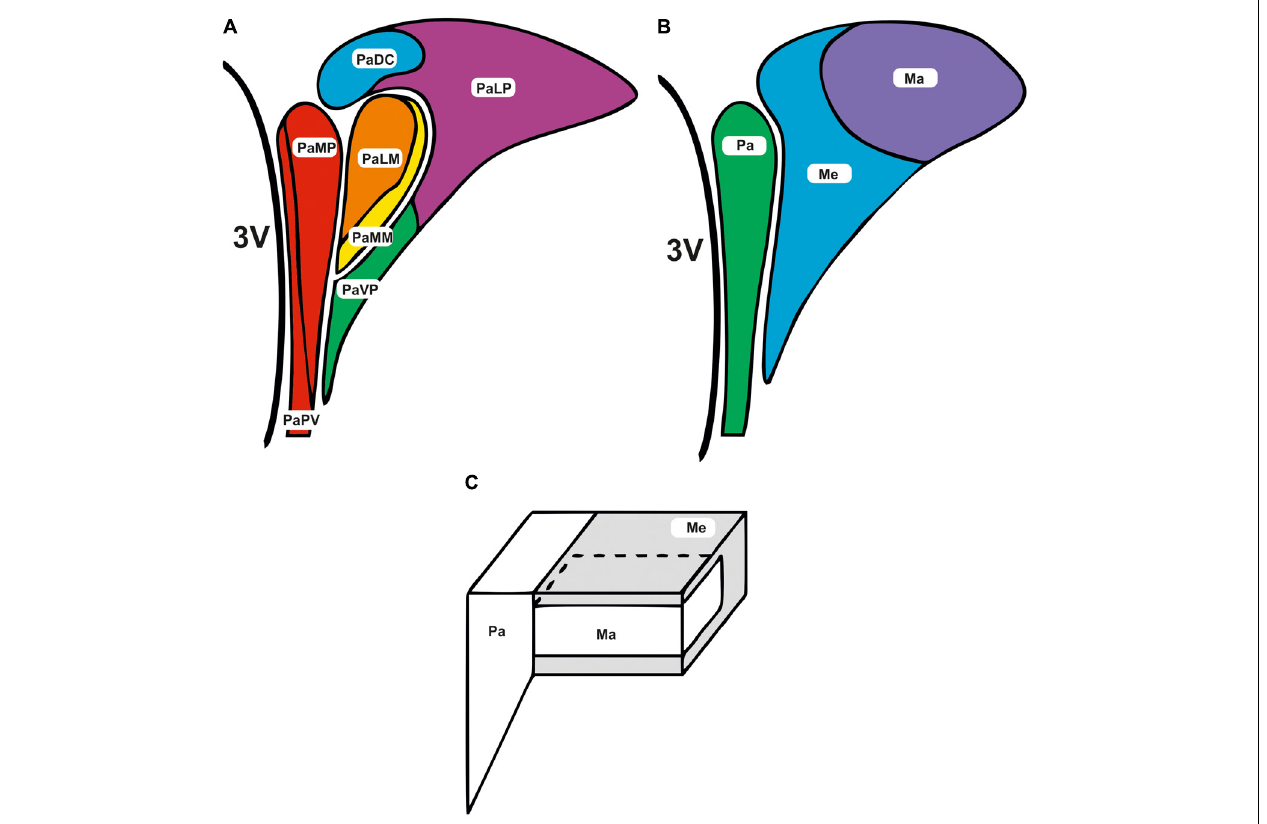
FIGURE 1 | Subdivisions of the paraventricular nucleus. The subdivisions of the PVN are adjacent to the third ventricle (3V). (A) Parvocellular and magnocellular regions are further subdivided into the following areas; lateral magnocellular (PaLM), medial magnocellular (PaMM), medial parvocellular (PaMP), lateral parvocellular (PaLP), periventricular subnucleus (PaPV), medial ventral parvocellular (PaVP), and dorsal cap (PaDC) (Paxinos and Watson, 1986; Koutcherov et al., 2000). (B,C) Alternatively the PVN can be divided more loosely into the parvocellular (Pa), posterior magnocellular lateral (Ma), and the intermediocellular regions (Me) (Kiss et al., 1991; Chen et al.,